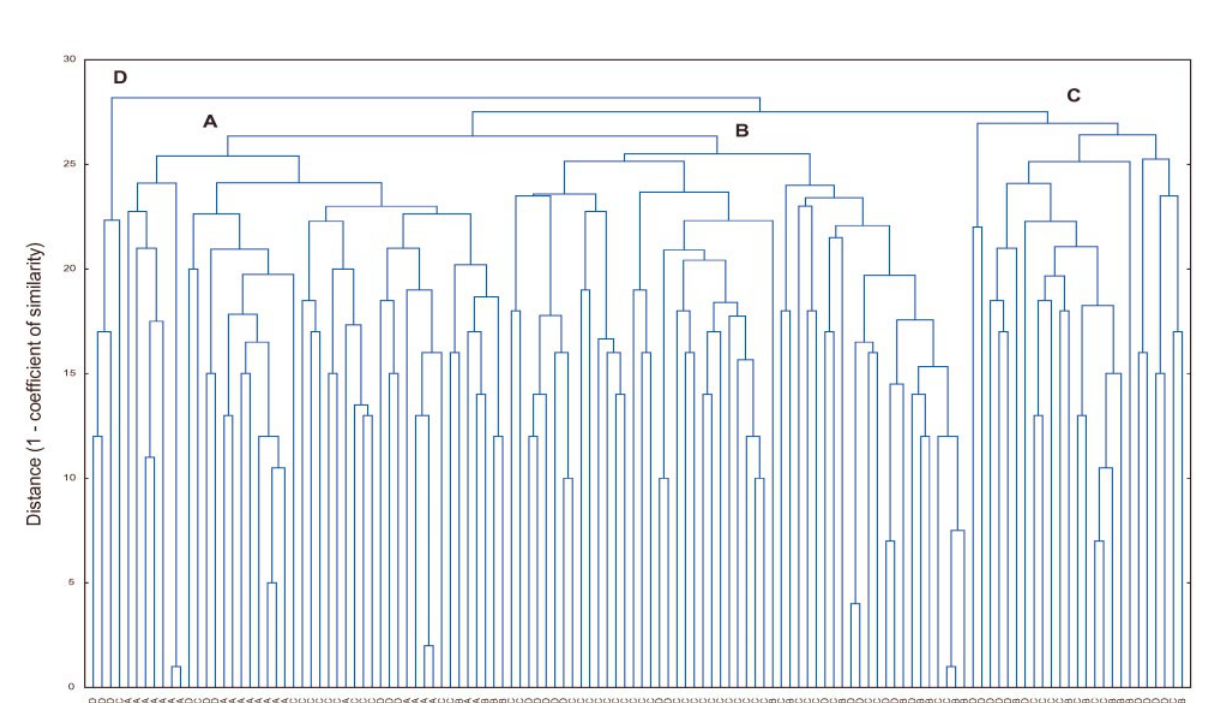
Figure 2 - Dendrogram based on UPGMA model calculated from genetic distances among American cassava genotypes from Santa Isabel (A), São Paulo (B), Brazil (C) and world collection (D), employing 88 RAPD